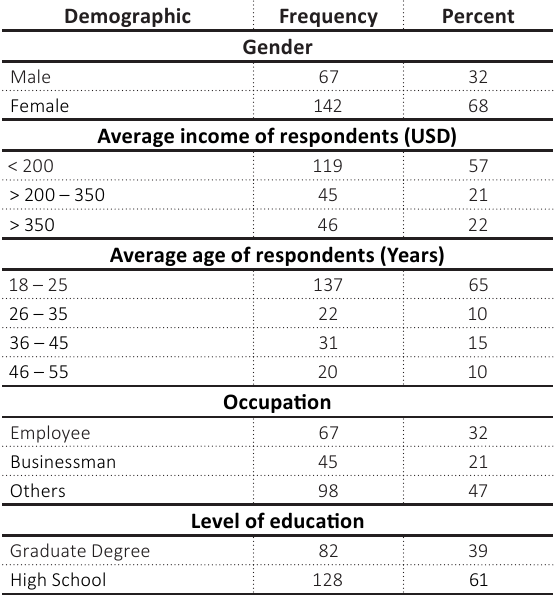
Table 4. Mean score for self-orientation